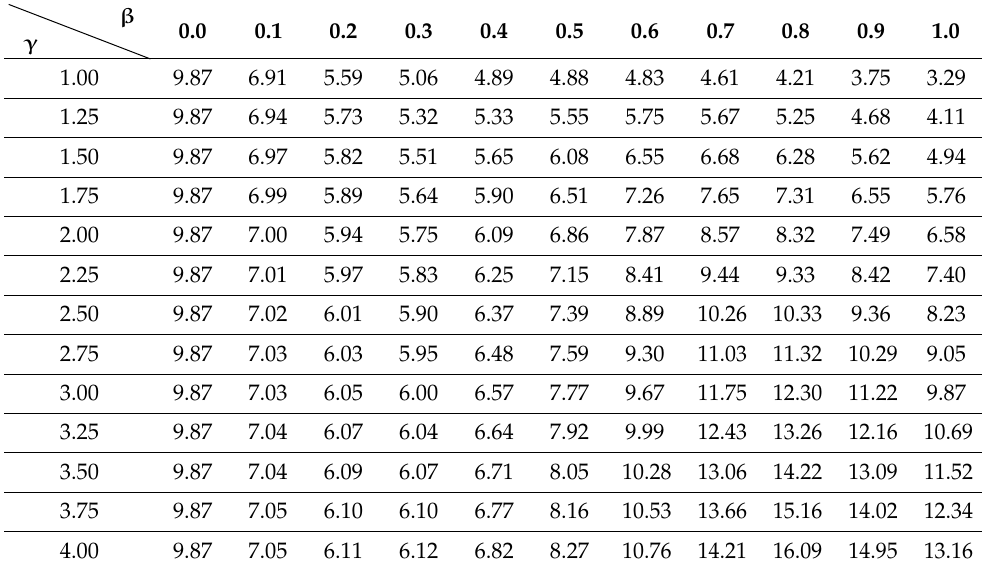
Table 5. Values P g /P d for α = 2.0 and for different values β and γ